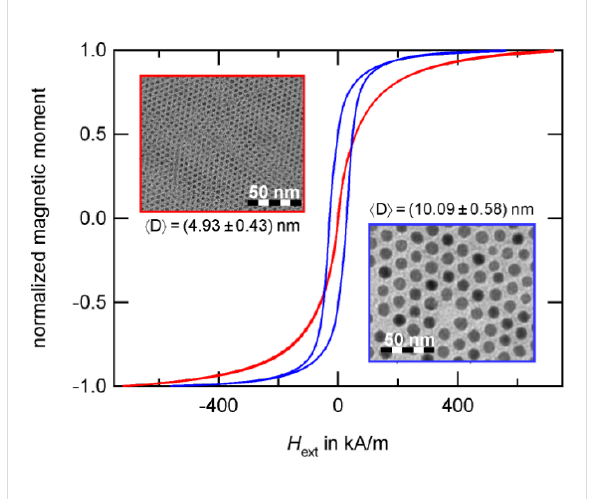
Figure 7: Co particles with a diameter of 4.9 and 10 nm measured at room temperature shortly after the preparation of particles. With the superparamagnetic limit at 7.8 nm [13], the larger particle species (blue) shows a hysteresis while the small particles (red) are superpara- magnetic at room temperature.